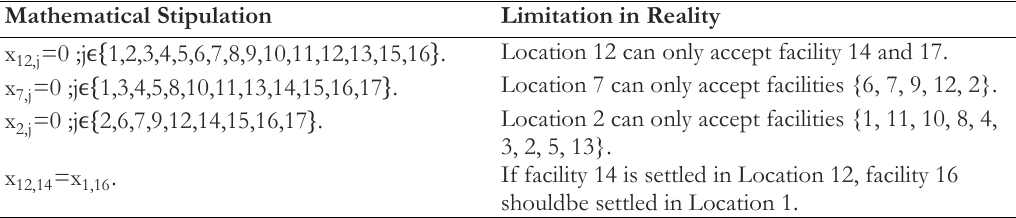
Table 3. Explanation of new stipulations.